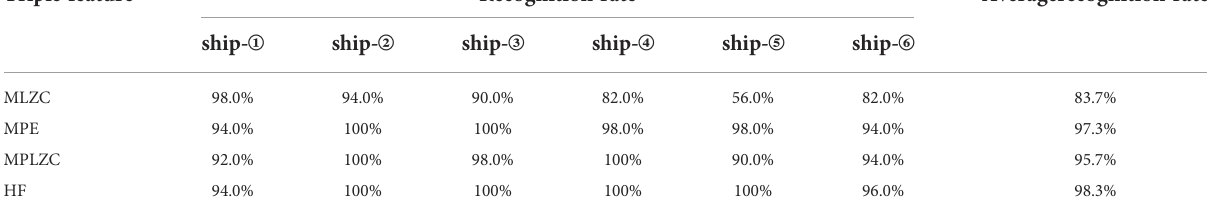
TABLE 2 The ARRs of the triple feature extraction methods for six S-Ss.